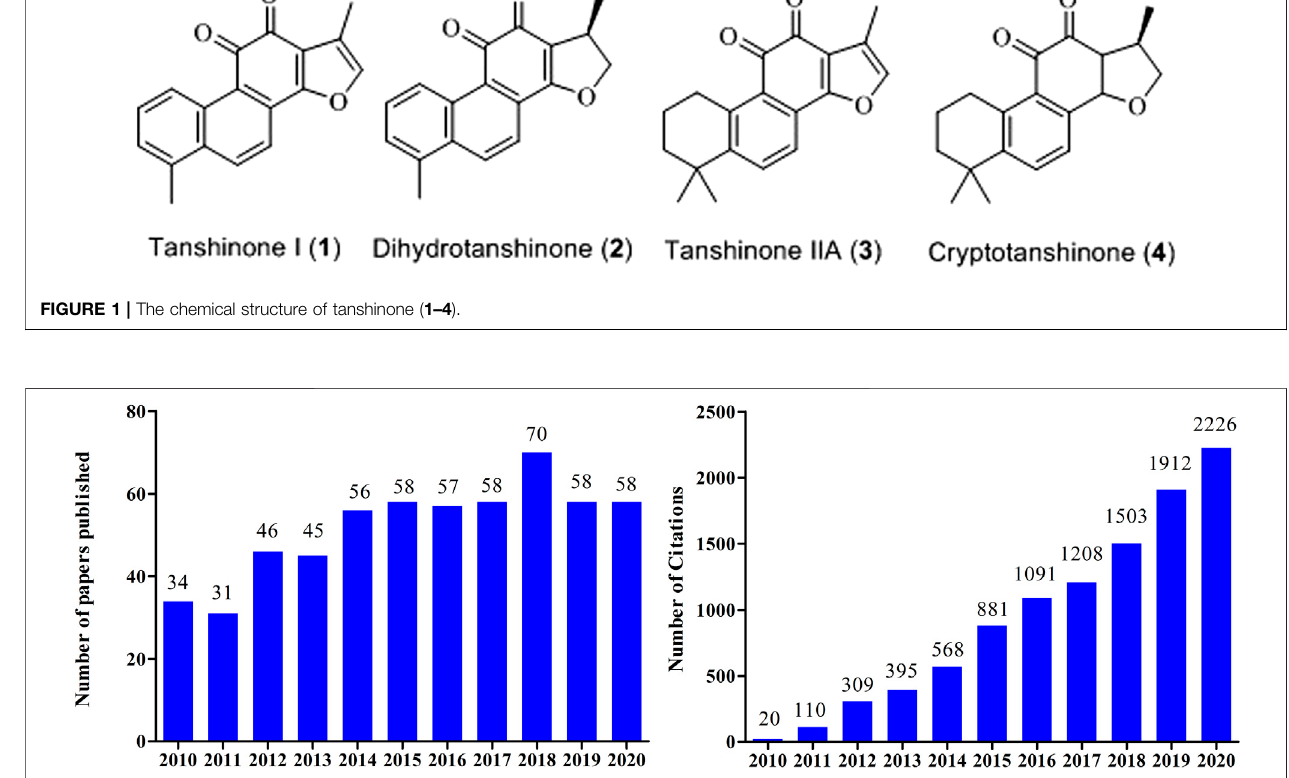
Frontiers in Pharmacology |